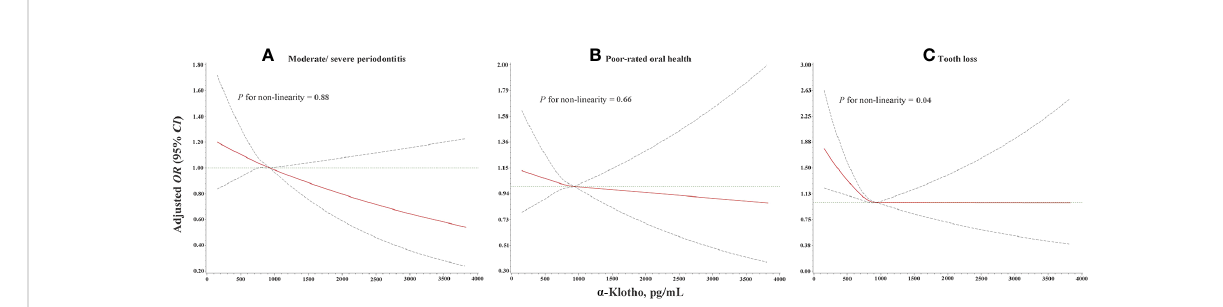
FIGURE 3 Dose-response relationship of a -klotho with (A) moderate/severe periodontitis, (B) poor-rated oral health, and (C) tooth loss from RCS analysis with three knots at the 25th, 50th, and 75th percentiles with adjustment for age, sex, race, educational level, marital status, family poverty income ratio, smoking status, drinking status, physical activity level, BMI, diabetes mellitus, hypertension, and eGFR. OR, odds ratio; 95% CI, 95% con fi dence interval; RCS, restricted cubic splines; BMI, body mass index; eGFR, estimated glomerular fi ltration